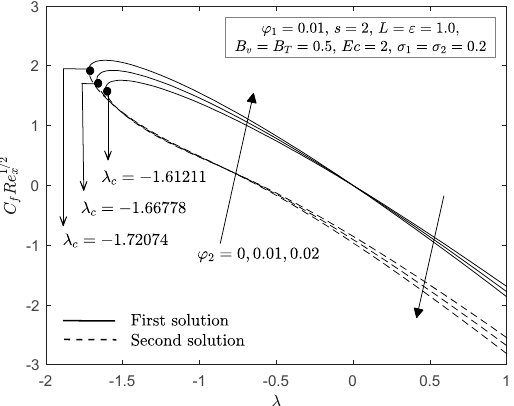
Figure 4. Figure 4. C f Re 1/2 x with λ for various ϕ 2 .